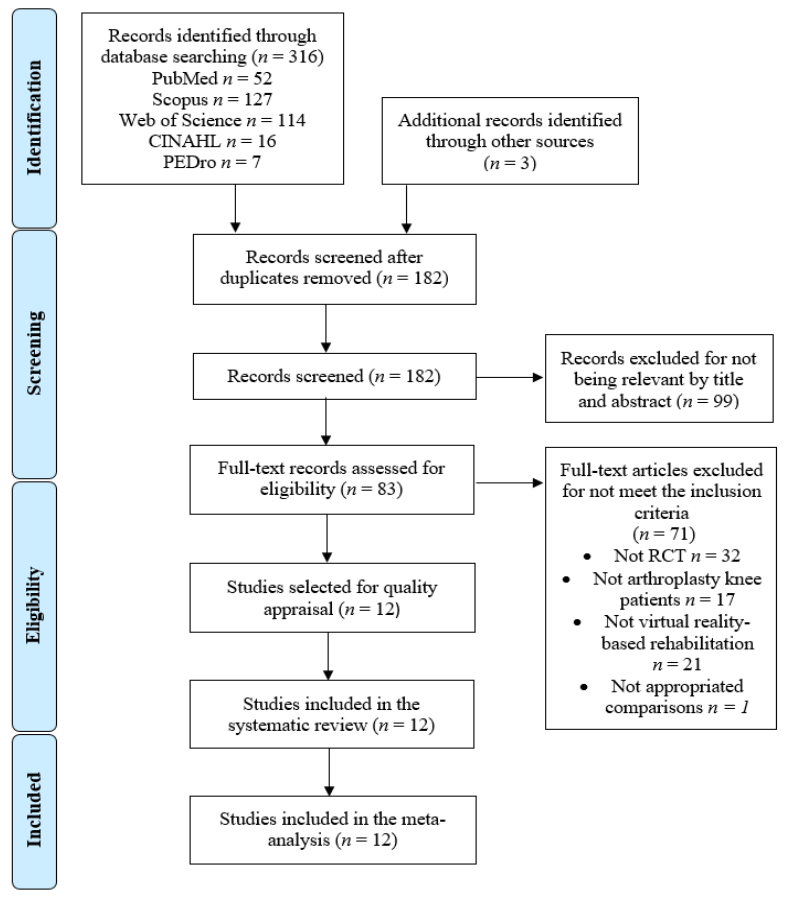
Figure 1. PRISMA flow diagram of the study selection process.